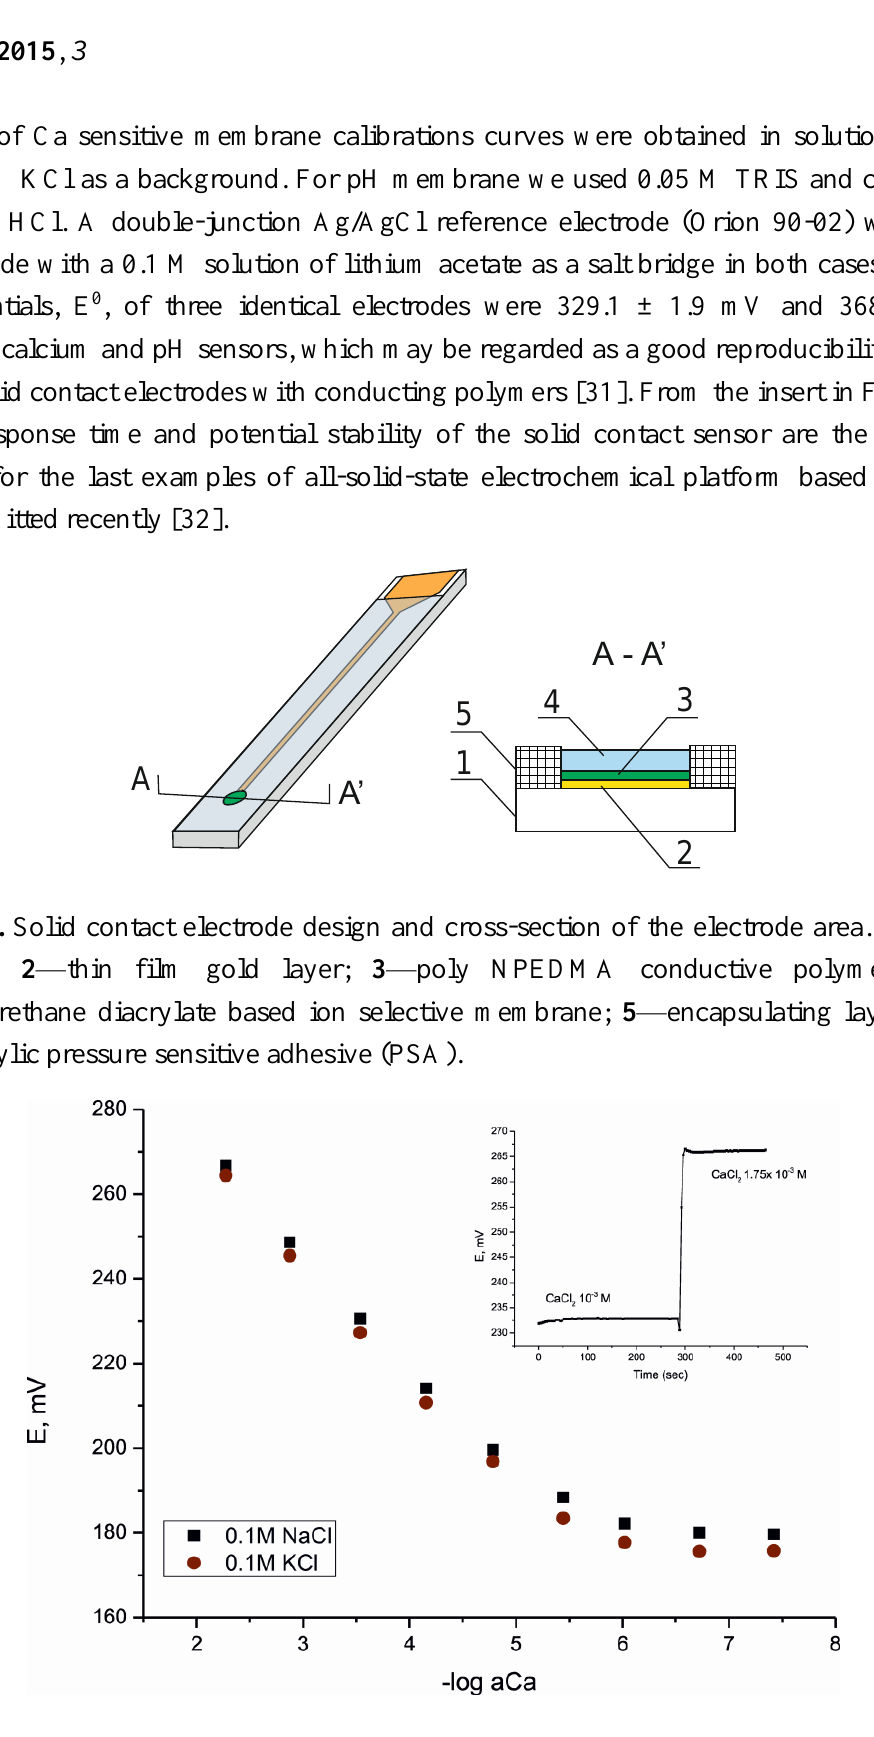
Figure 3. Calibration curves for Ca-selective electrodes (mean values for 3 sensors) in solutions with 0.1 M NaCl and 0.1 M KCl as a background. Insert: Response time of the electrodes in pure solutions of CaCl 2